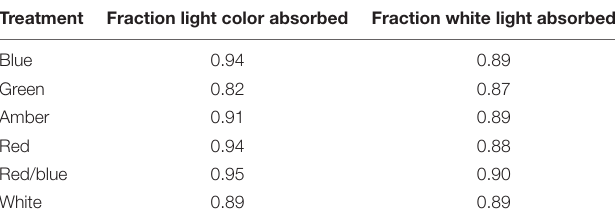
TABLE 2 | Effects of spectral composition on the fractions of light absorbed.